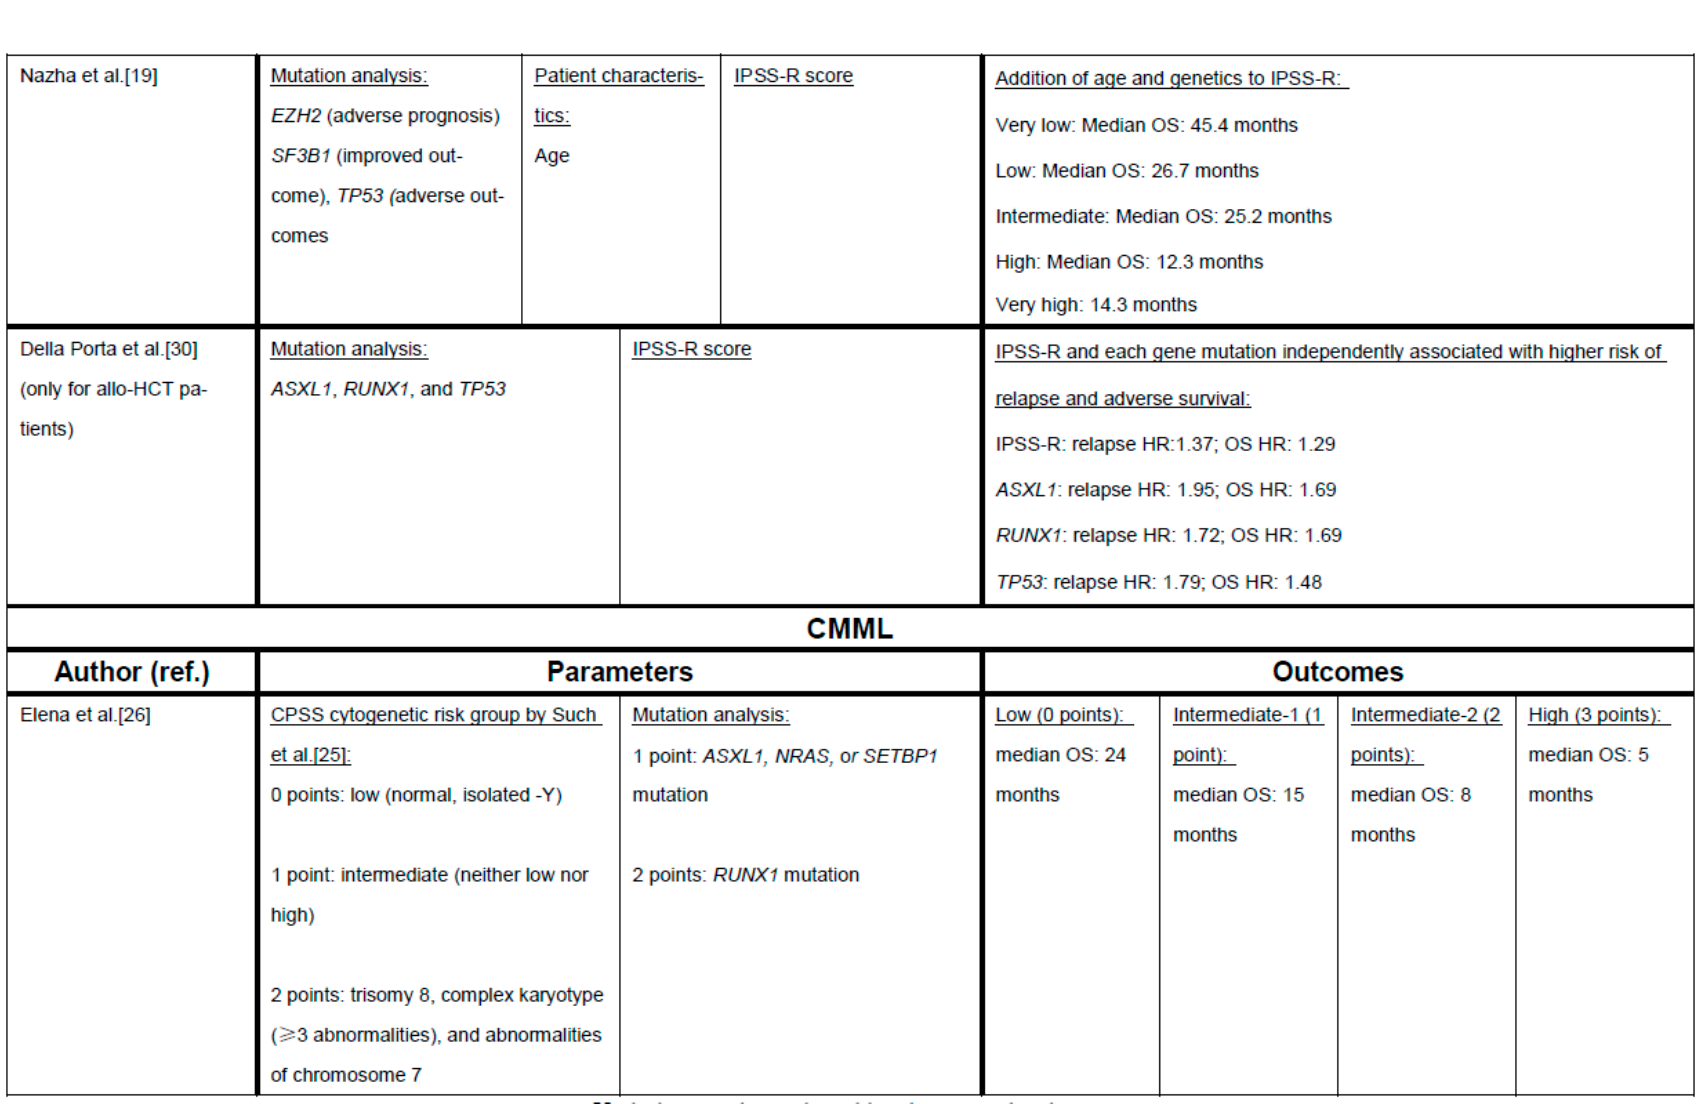
Figure 2. Selected molecular risk stratification tools for MDS and CMML. Underlines: indicate the subheading in each column [18,19,26,30].